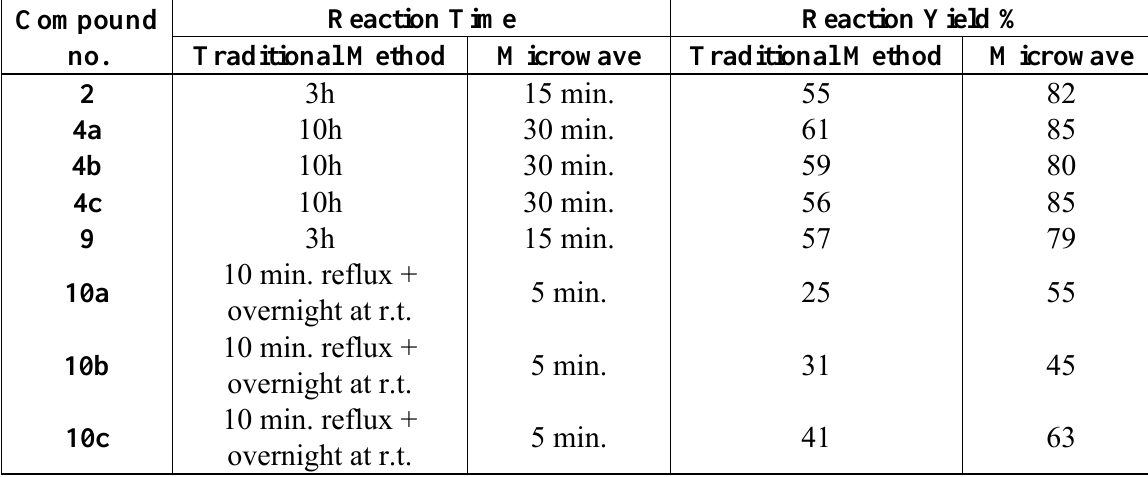
Table 1. Comparison between traditional methods and microwave assisted methods of synthesis of compounds 2 , 4 , 9 and 10